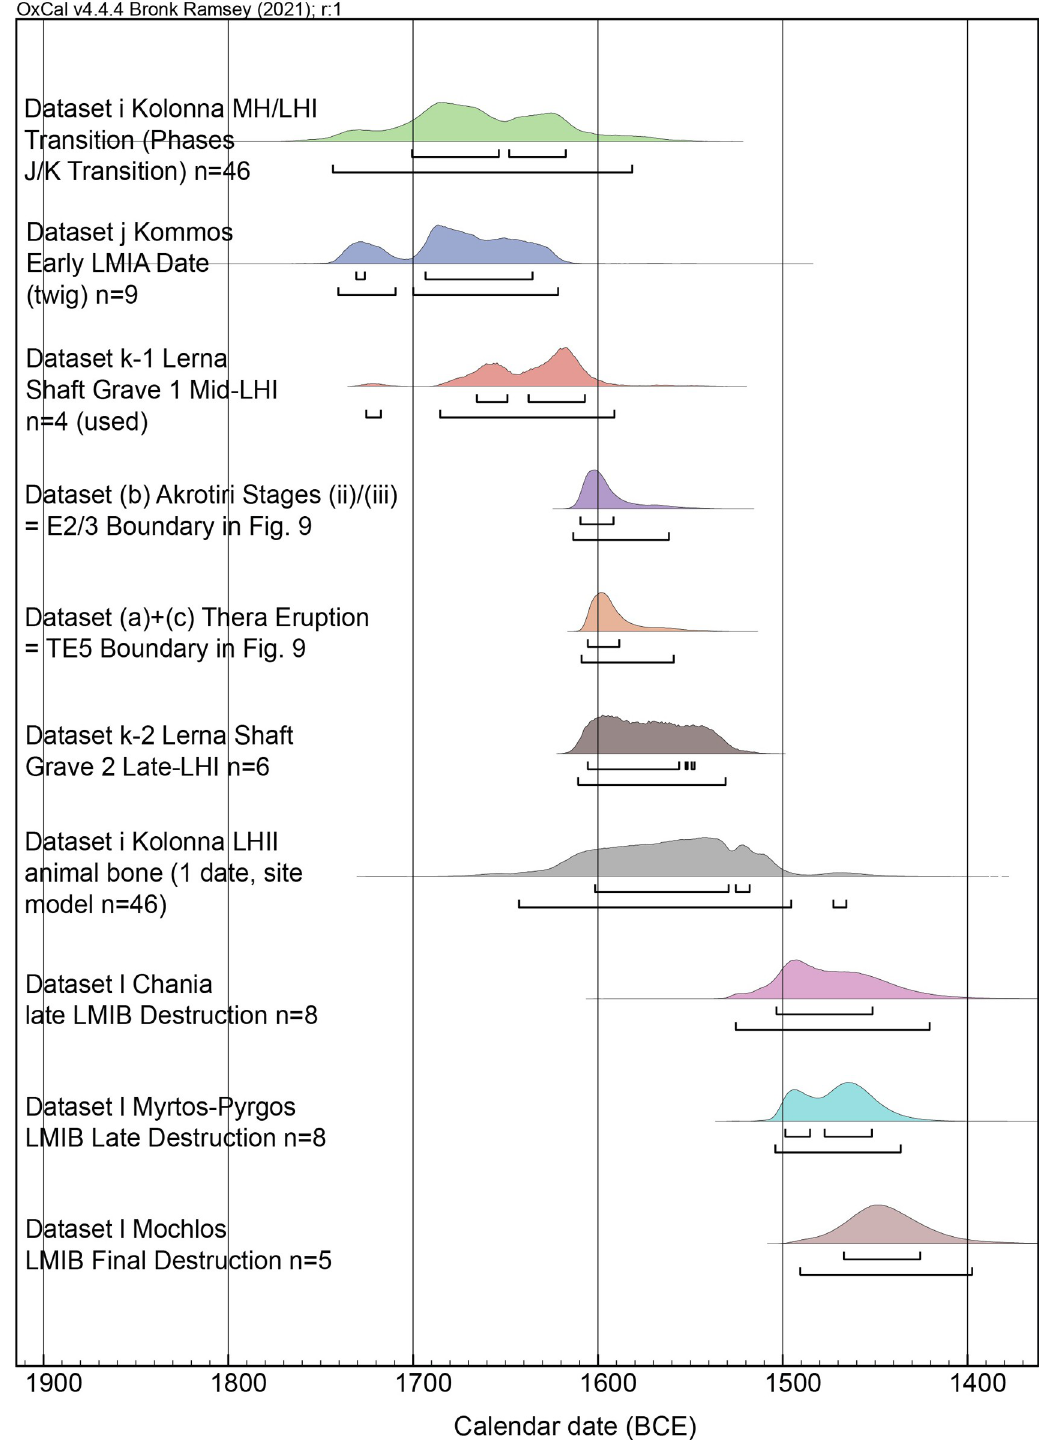
Fig 10. Modelled posterior probability distributions for datasets from Aegean LMIA or LCI or LHI-II contexts prior to, or around, or shortly after, the Thera eruption, and LMIB destruction datasets from the close of the subsequent archaeological period on Crete. For the 68.3% and 95.4% hpd ranges indicated, see Table 5. The datasets offer a coherent chronological sequence.